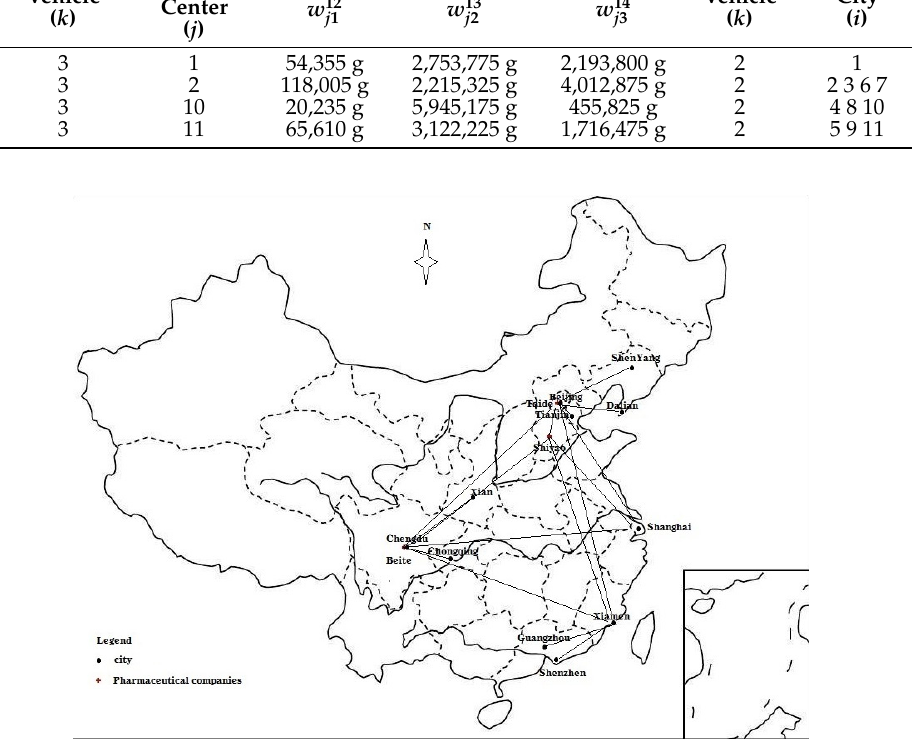
Figure 2. Diagram of optimized medicine distribution path.